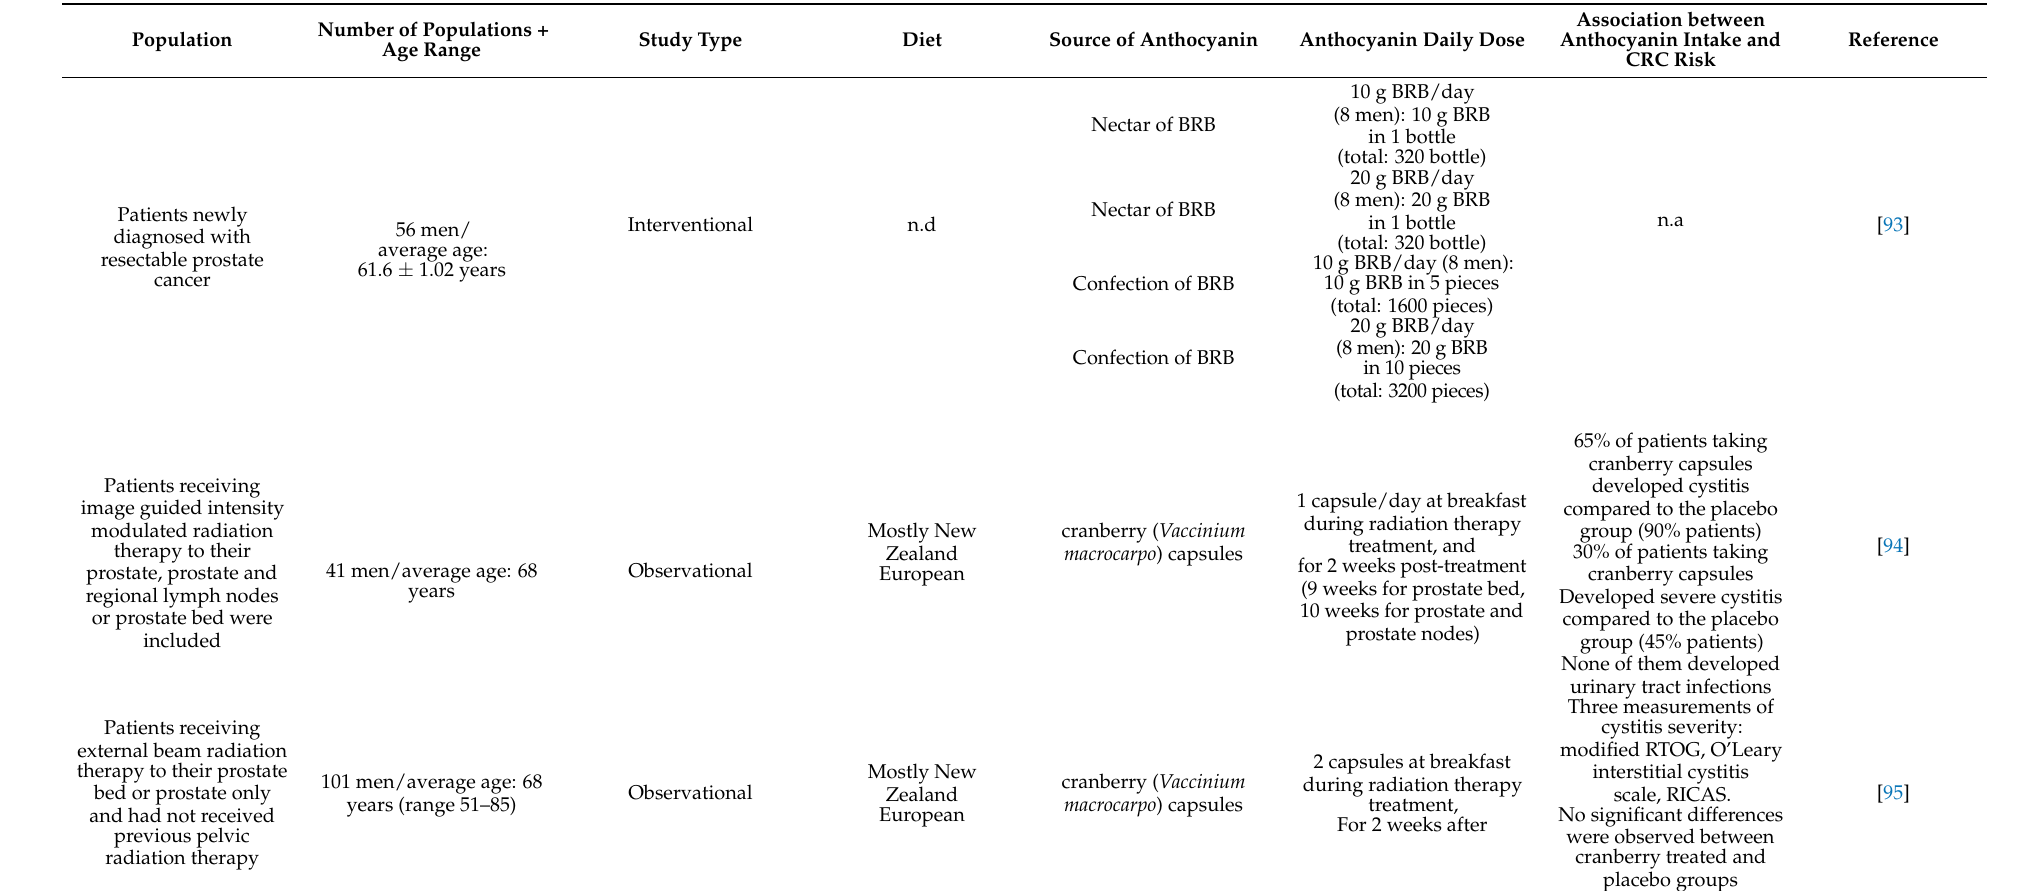
Table 3. Clinical trials evaluating the efficacy of anthocyanins on prostate cancer